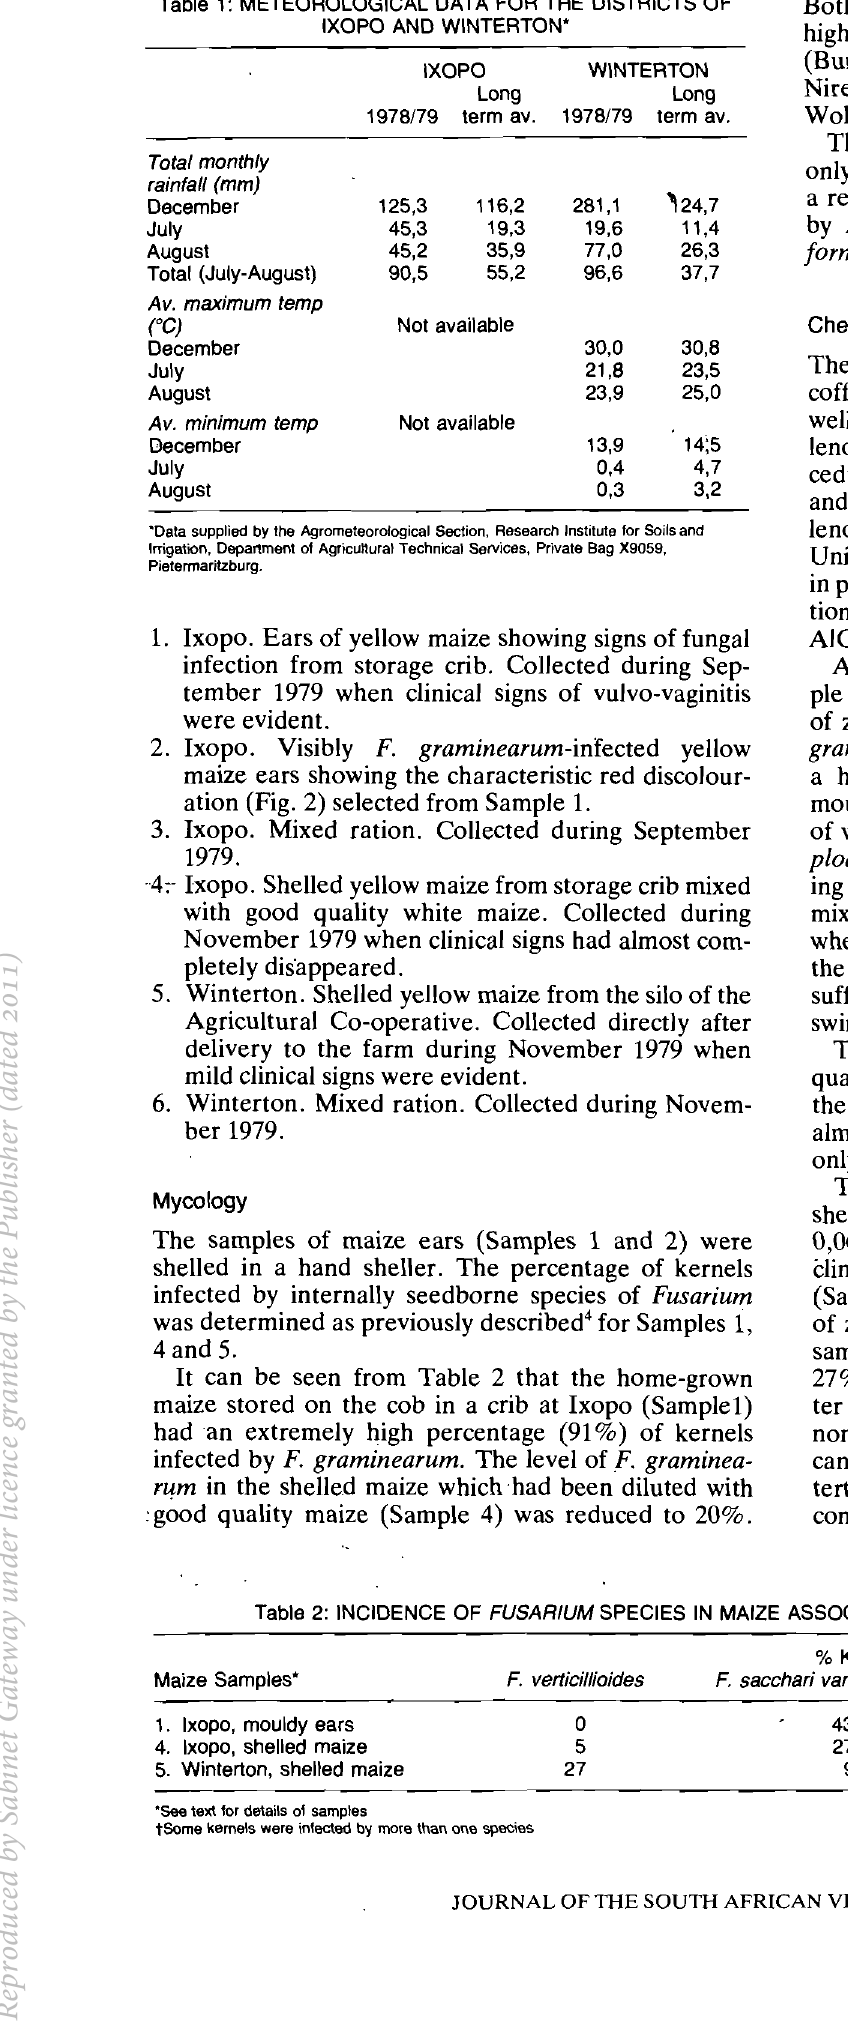
Table 1: METEOROLOGICAL DATA FOR THE DISTRICTS OF IXOPO AND WINTERTON'